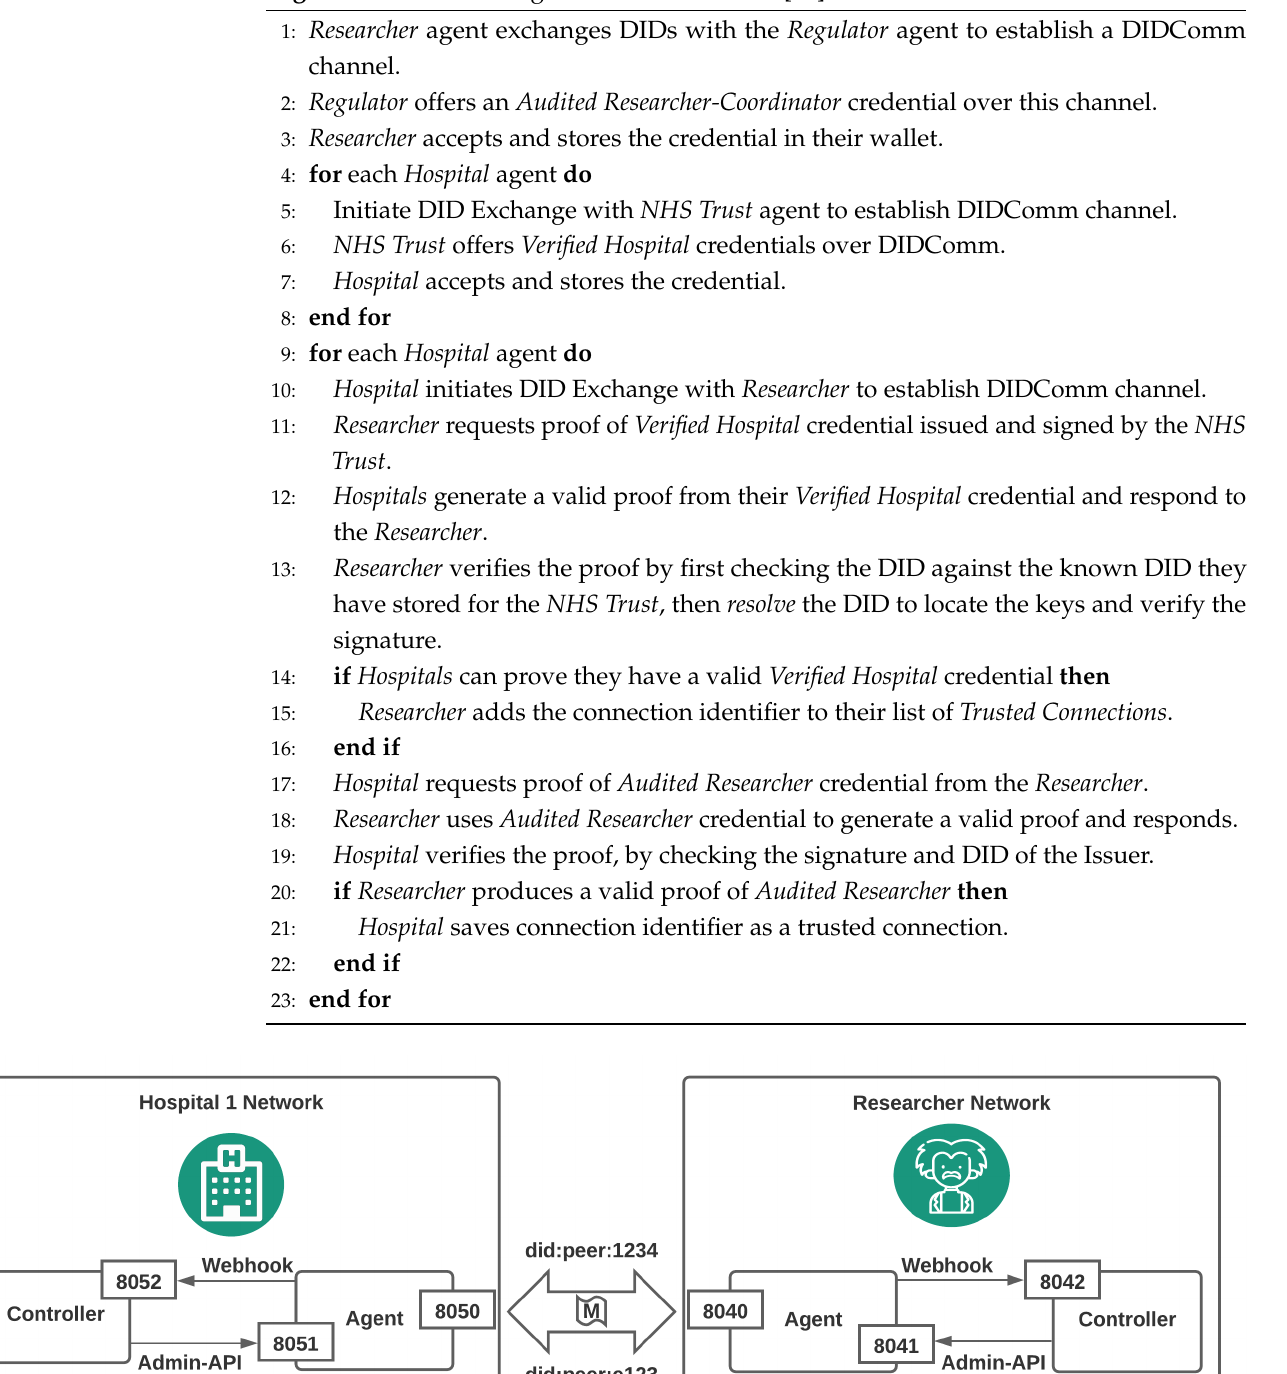
Algorithm 2 Establishing Trusted Connections [27]